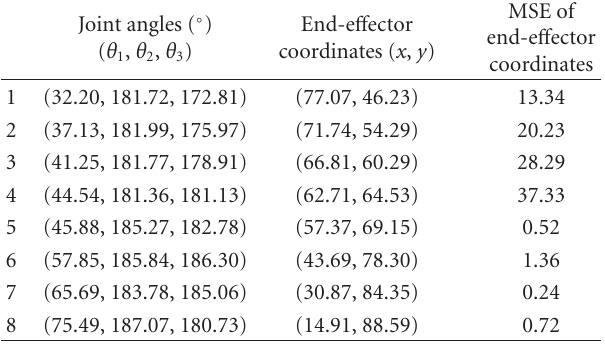
Table 3: Estimated joint angles, calculated end-e ff ector coordi- nates, and errors for ill-posed problem with no solution.